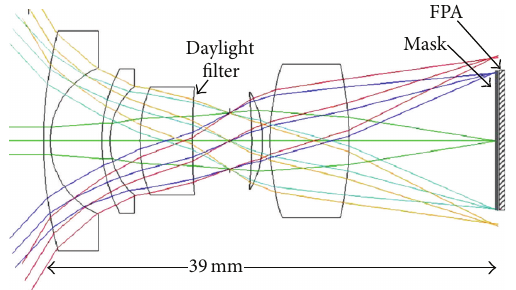
Figure 5: Optical layout of receiver.